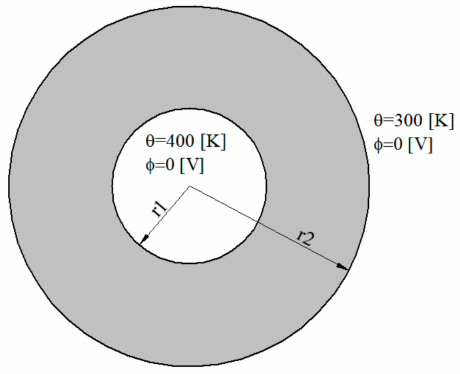
Figure 6. Geometry and boundary